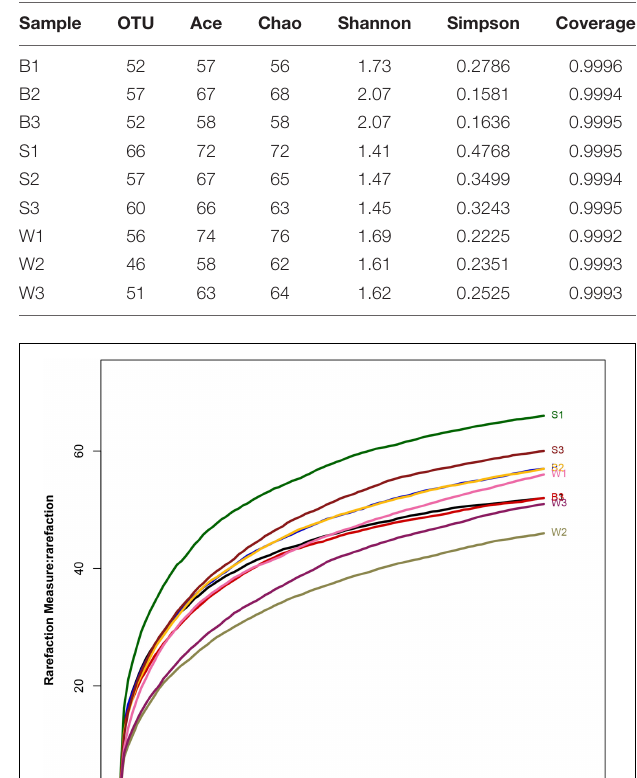
indicating the diversity in San qu was lower than that in Bing Wan and Jiu Bing , which also demonstrated by Simpson indexes in Table 1 . All samples had a high Good’s coverage (99.9%).